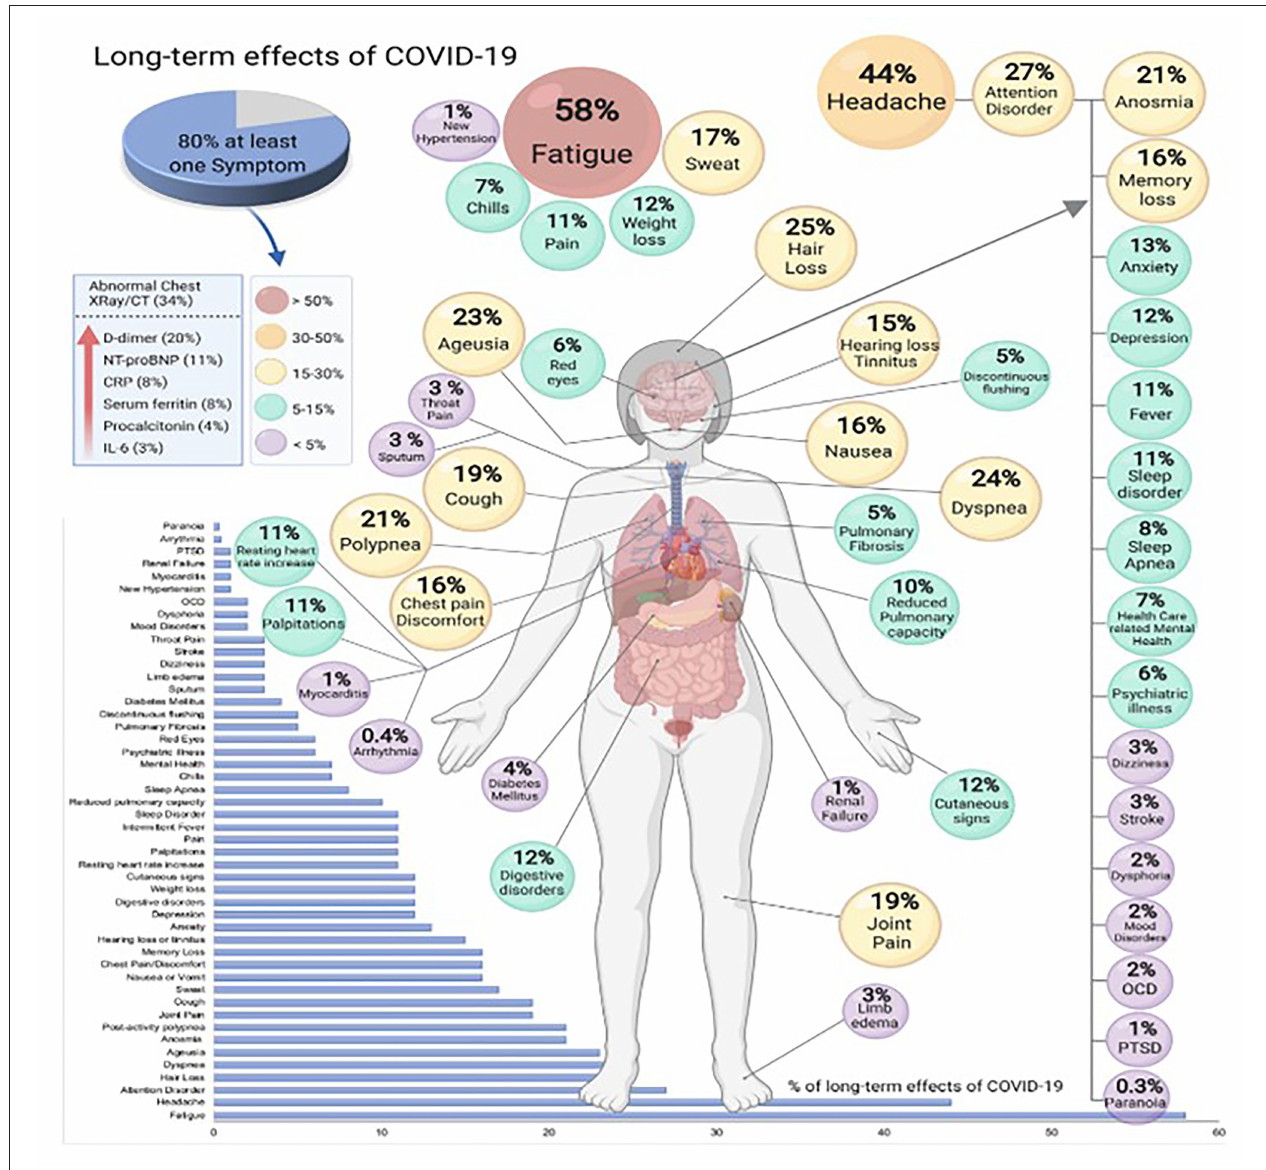
FIGURE 6 | Long-term effects of COVID-19 (produced with permission)